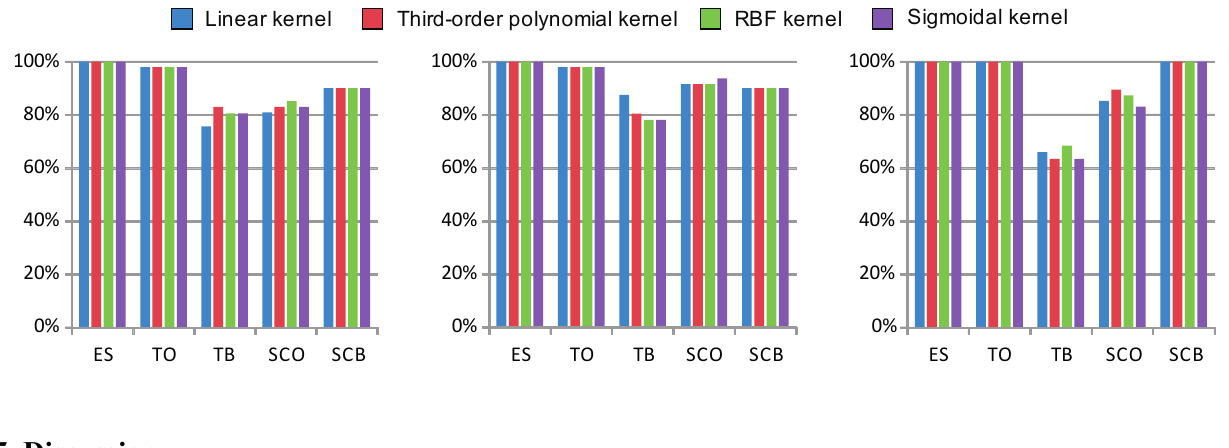
Figure 8. Cross-validation accuracy for each kernel under the following working conditions—( ES ) engine speed, ( TO ) threshing cylinder operation, ( TB ) threshing cylinder balance, ( SCO ) straw chopper operation, and ( SCB ) straw chopper balance—using the accelerometer channel corresponding to ( a ) the transverse X axis; ( b ) the longitudinal Y axis; and ( c ) the vertical Z